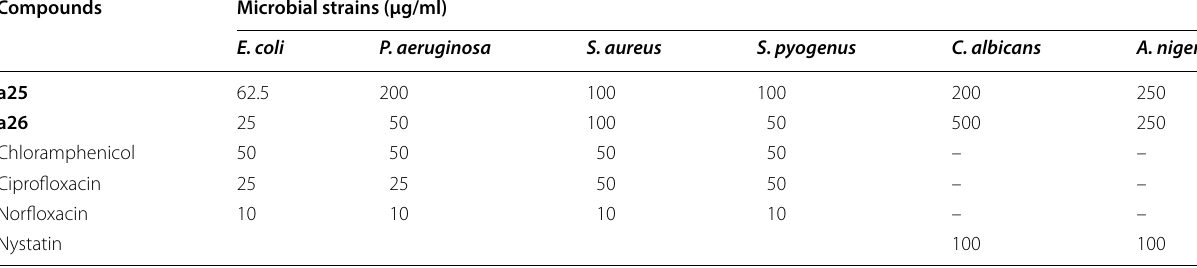
Table 12 Antimicrobial activity of compounds a25 and a26 Compounds